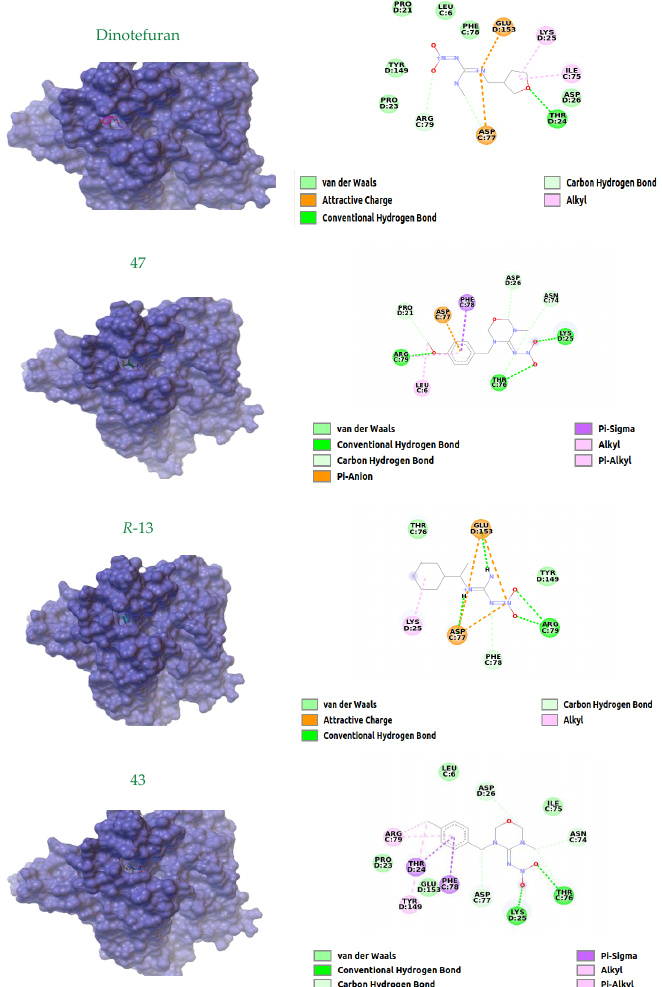
Figure 7. The 2D and 3D representations of the interaction of dinotefuran and compounds 47 , R - 13 , and 43 , with the residues of the search cavity in 3C79.